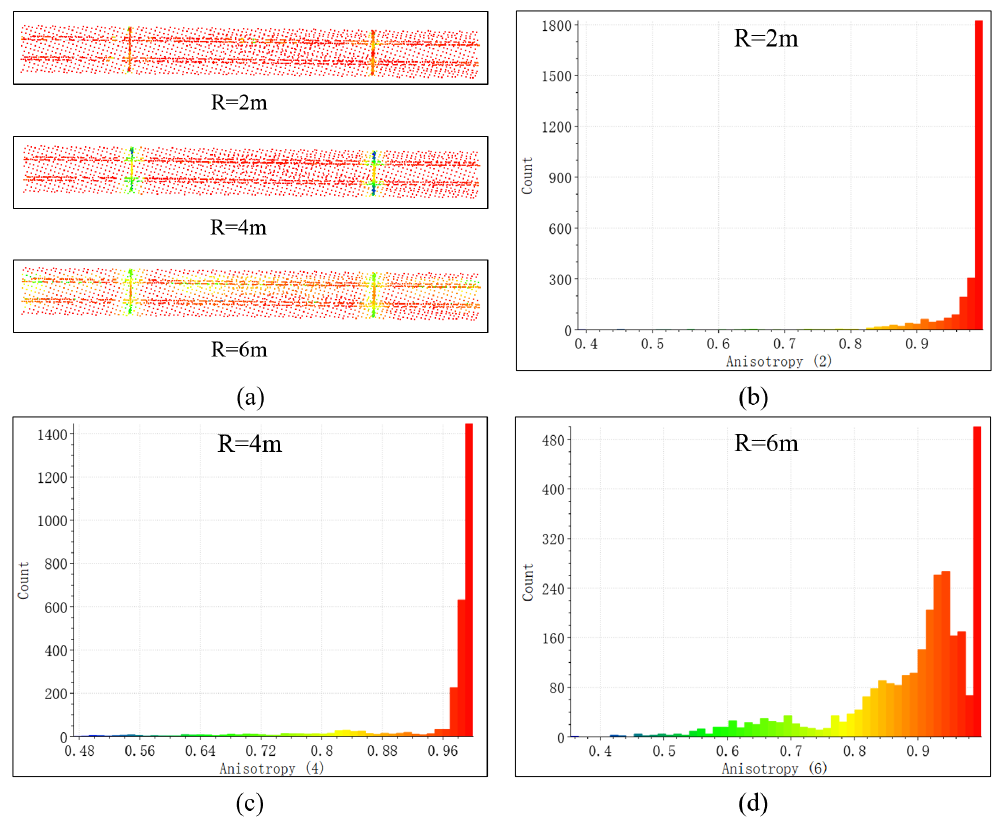
Figure 13. The anisotropy value with different neighbourhood radius. ( a ) anisotropy values with radius 2, 4, and 6 m; ( b – d ) are the distributions of anisotropy value with the radius, respectively.